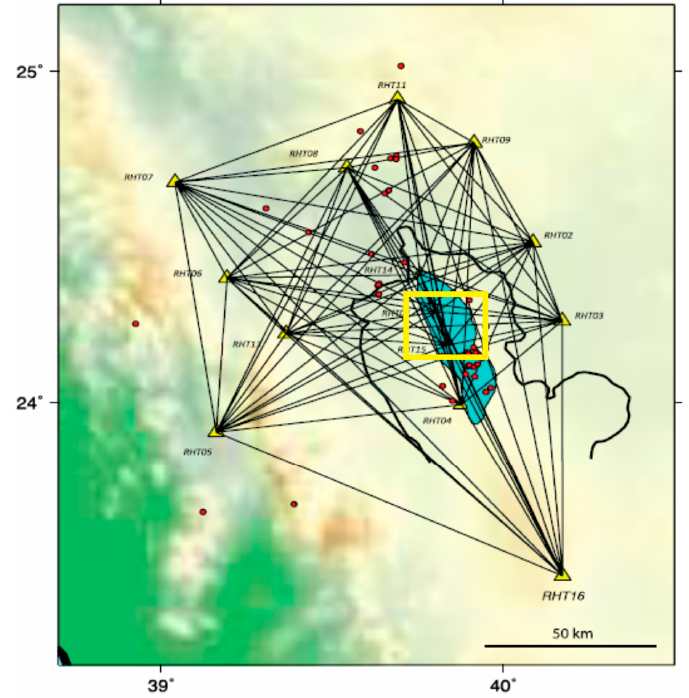
Figure 3. The ray paths covered by the ambient noise correlation showing seismic stations (RHTs) and the outline of northern Harrat Rahat. The blue area denotes an area of a likely high subsurface heat flow based on the young volcanics as mapped from the surface geology. Velocity models have been generated for each path (modified from [1]).